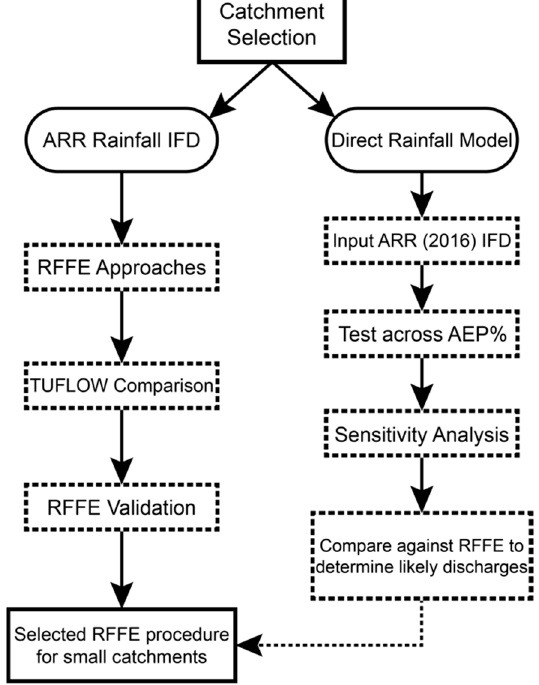
Figure 2. Workflow of steps to determine Regional Flood Frequency Estimation (RFFE) selection and for small headwater channels.